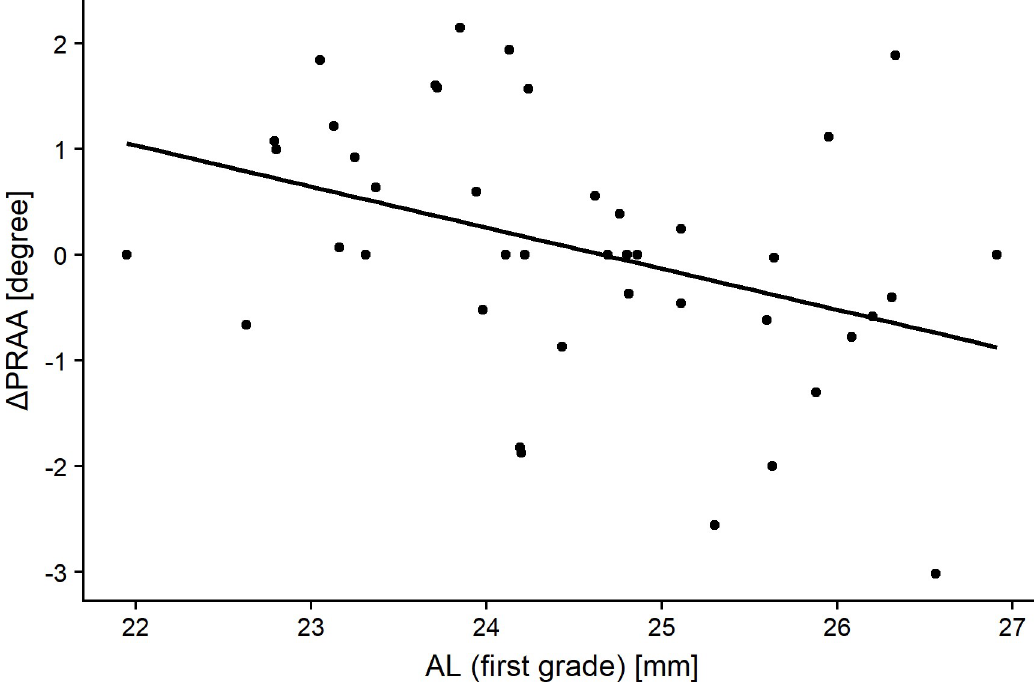
Fig 4. The relationship between the change in the peripapillary retinal arteries angle ( Δ PRAA) and axial length (AL) in subjects when in the first grade. Significant correlations were obtained (R = -0.39, p = 0.012, Pearson’s product-moment